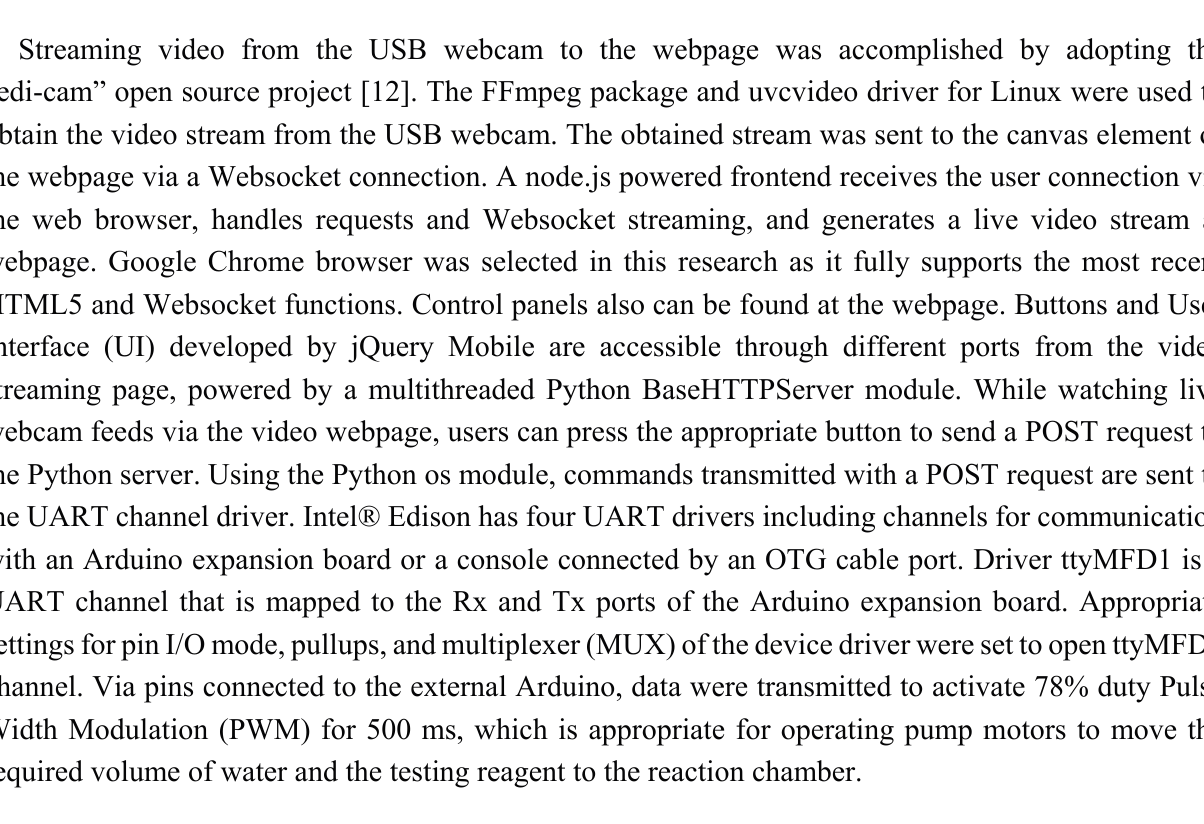
Figure 4. Overall architecture of the